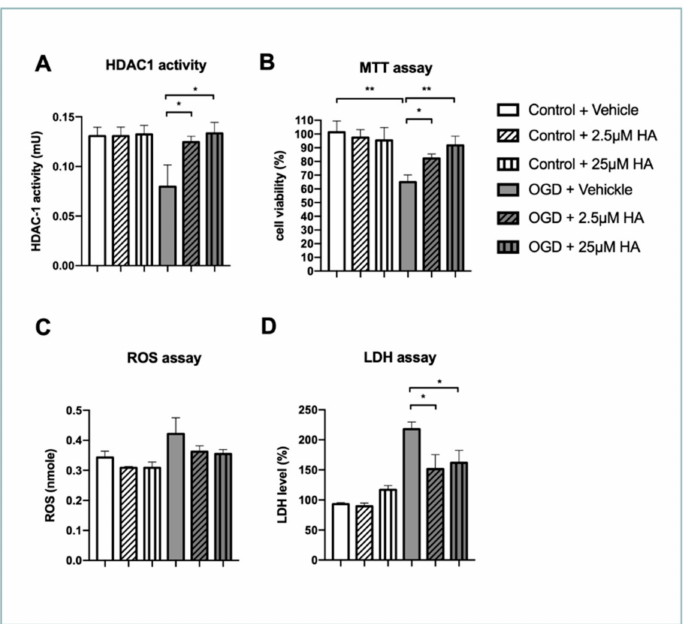
Figure 1. HA treatment restored HDAC1 enzymatic activity and protected neuronal damage after OGD in vitro. ( A ) HDAC1 activity assay was conducted 24 h after OGD. HDAC1 was isolated from protein lysates extracted from primary neuron by immunoprecipitation, and then HDAC1 activity was detected by the assay kit. ( B ) Cell viability was evaluated by MTT assay 24 h after OGD. ( C ) Protein lysates extracted from primary neuron were subjected to ROS assay 24 h after OGD. ( D ) Neuronal damage was evaluated by LDH assay 24 h after OGD. n = 6. * Denotes p < 0.05, ** denotes p <